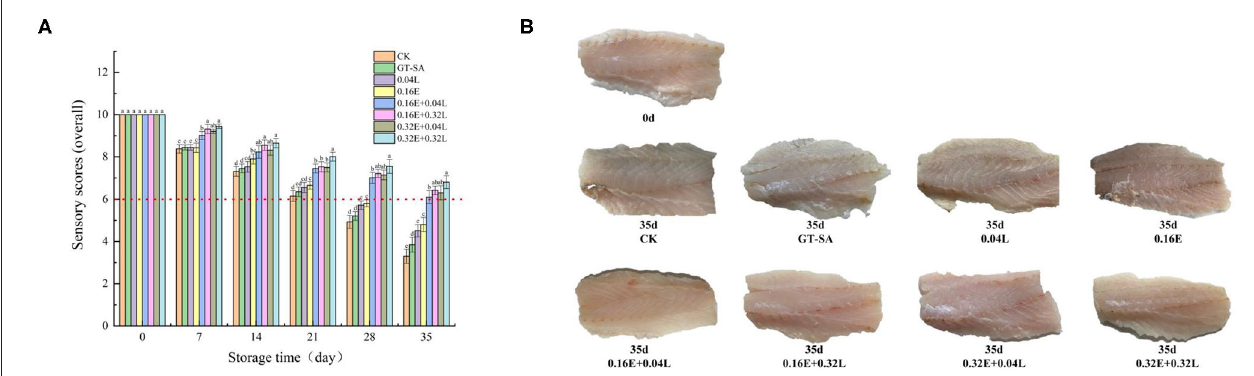
FIGURE 3 | Changes in sensory score (A) and surface imaging (B) of large yellow croaker samples during superchilling storage (CK, uncoated; GT-SA, GT-SA coating without preservatives; 0.04L, GT-SA coating with 0.04 mg · mL − 1 LYS; 0.16E, GT-SA coating with 0.16 mg · ml − 1 EGCG; 0.16E + 0.04L, GT-SA coating with